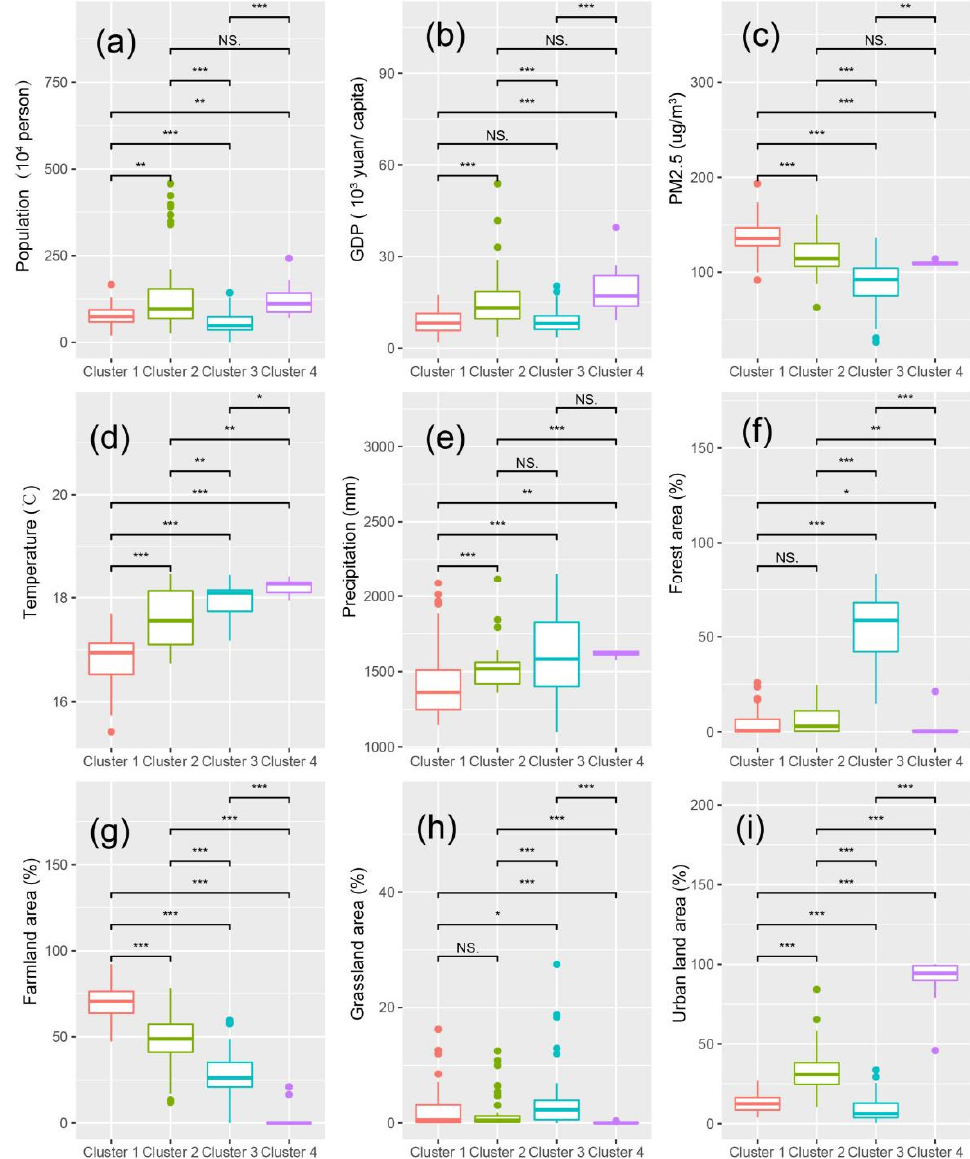
Figure 10. Differences in the human-environmental factors among the four identified clusters. ( a – i ) refers to Population, GDP, PM2.5, Temperature, Precipitation, Forest area, Farmland area, Grassland area, and Urban land area, respectively. Different symbols above the boxplots indicate significant different levels (* p < 0.05, ** p < 0.01, *** p < 0.001, NS. indicates no significance).